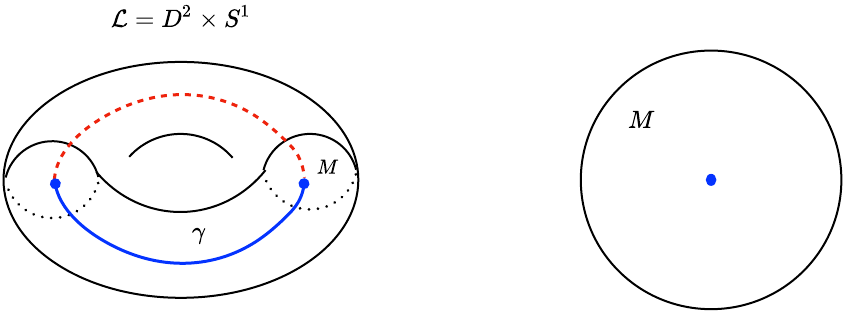
Figure 6 . Quantizing the worldvolume gauge theory with time running around the non-contractible cycle of L , we have to impose Gauss’s law on M . The puncture on M corresponds to the anyon charge on the Wilson loop which sources Gauss